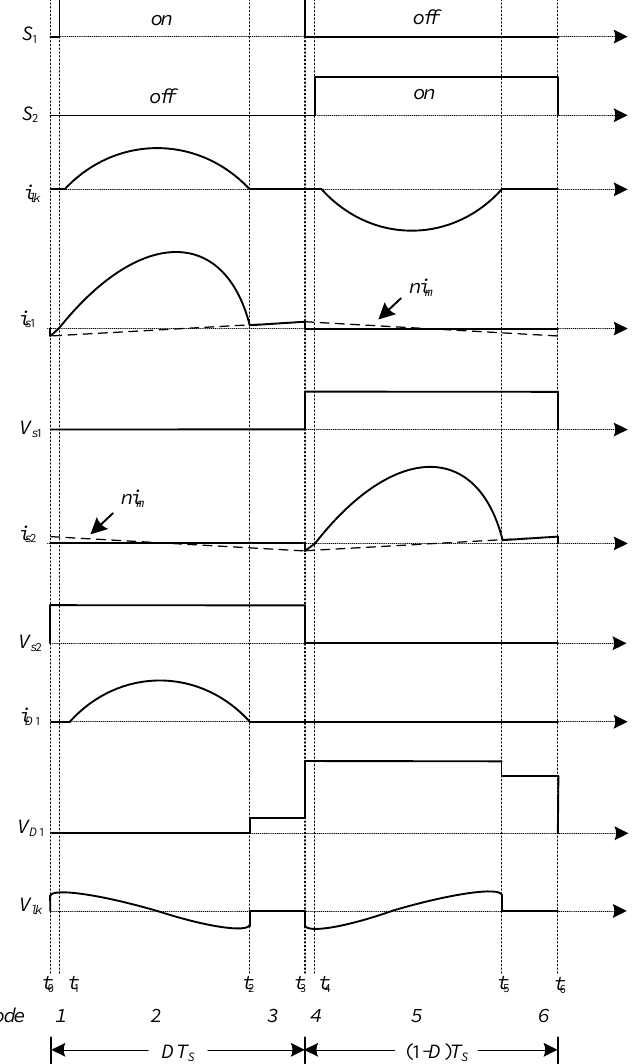
Figure 4. Waveforms of the proposed DC–DC converter according to operating modes of DCM.